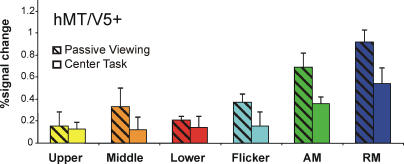
Attentional Modulation of Activity in hMT/V5+ in Experiment 2Responses to the different conditions in experiment 2 for the region hMT/V5+ are shown. The bars designate percentage signal change of the peak response relative to baseline (see Materials and Methods). The hatched bars are activations from runs with passive viewing only, and the solid bars are from runs with center task. The static conditions—upper, middle, lower, and flicker—induced only low activation in hMT/V5+. In contrast, the response to apparent motion and real motion was higher, corresponding with the motion sensitivity of hMT/V5+. The attentional modulation of the responses was very strong. Under all conditions, the activity was smaller during runs with center task than during runs with passive viewing. Error bars correspond to standard errors of the mean.